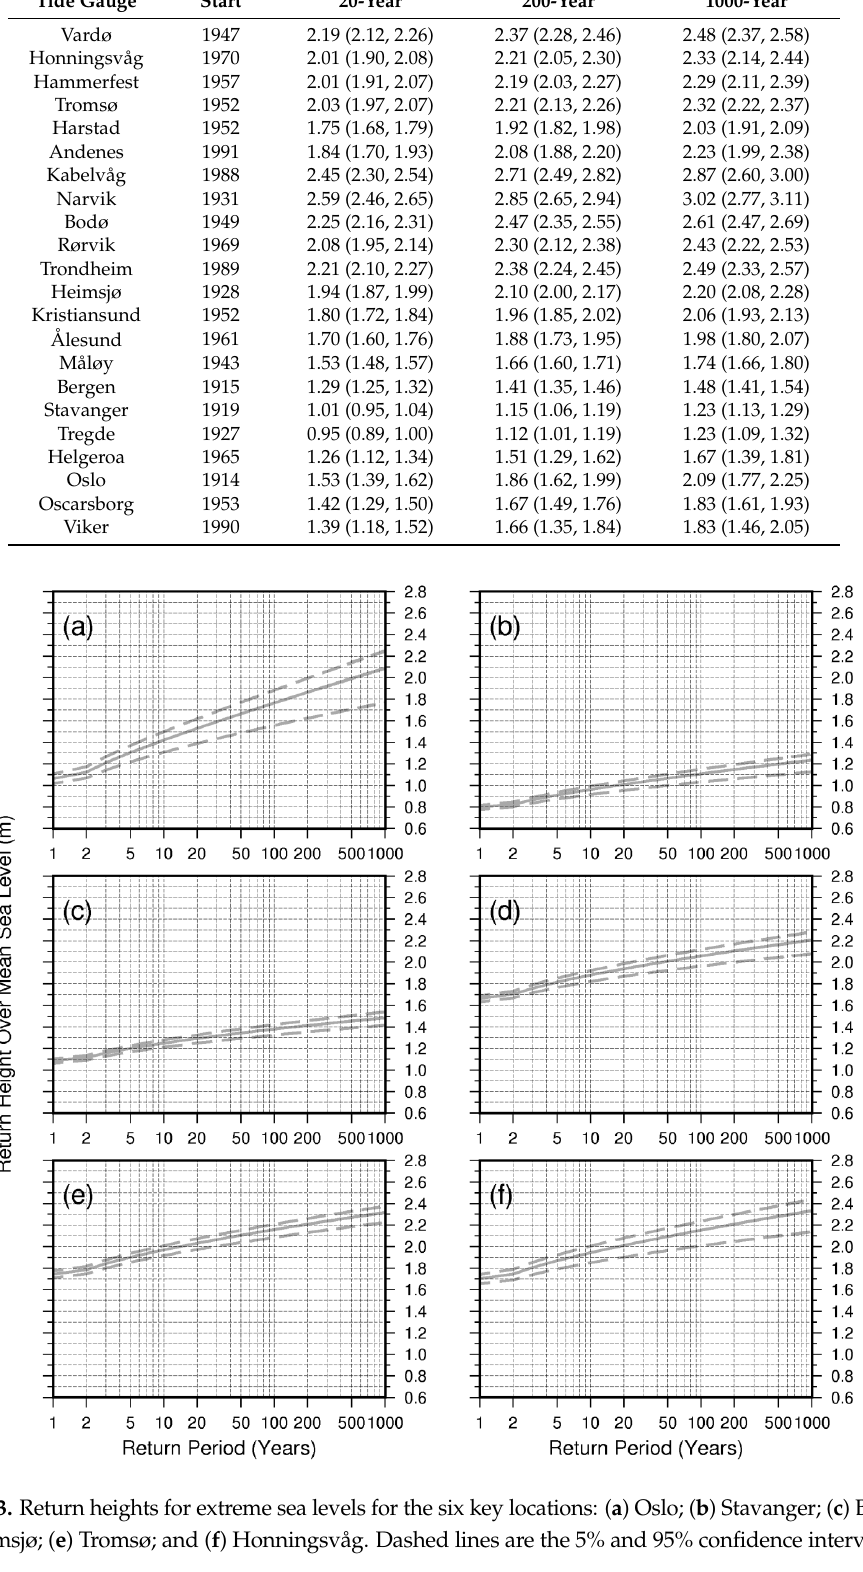
Table 1. Return heights for extreme sea levels calculated for the Norwegian tide gauges, given in meters above mean sea level (1996–2014). The 5% and 95% confidence levels are given in parentheses.